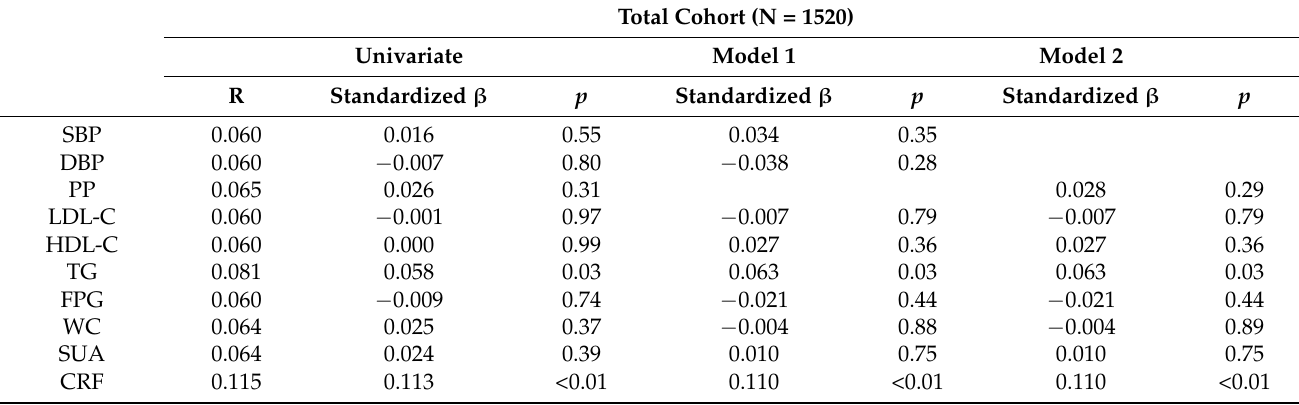
Table 2. Correlations of cardiorespiratory fitness and cardiometabolic risk factors with carotid intima–media